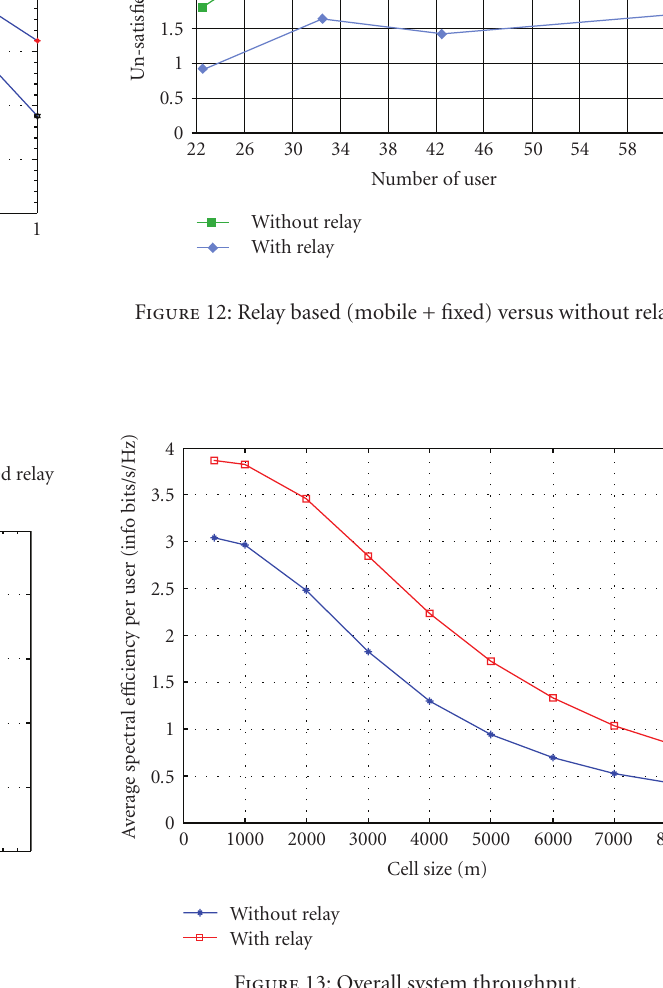
7/8 are also given out in Figure 10. The results for the m = 0 case corresponds to the no relay case. The simulation results show that the best range for the relay position is 2/3 to 3/4 away from the BS, when the transmit power ratio of the BS and the relay is 10 : 1. It agrees with our relay position design. In Figure 11, an average spectral e ffi ciency of 1.7 bits/sec/Hz can only be achieved in a small cell (500 m) without relays, while the same amount of average spectral e ffi ciency can be achieved in a medium cell (1000 m) with the help of relays. In other words, the system coverage with relays is four times as much as the coverage without relays, because the coverage area is proportional to the square of the radius. Figure 12 shows the case where fixed and mobile relay coexist in the cell. The percentage of unsatisfied users,